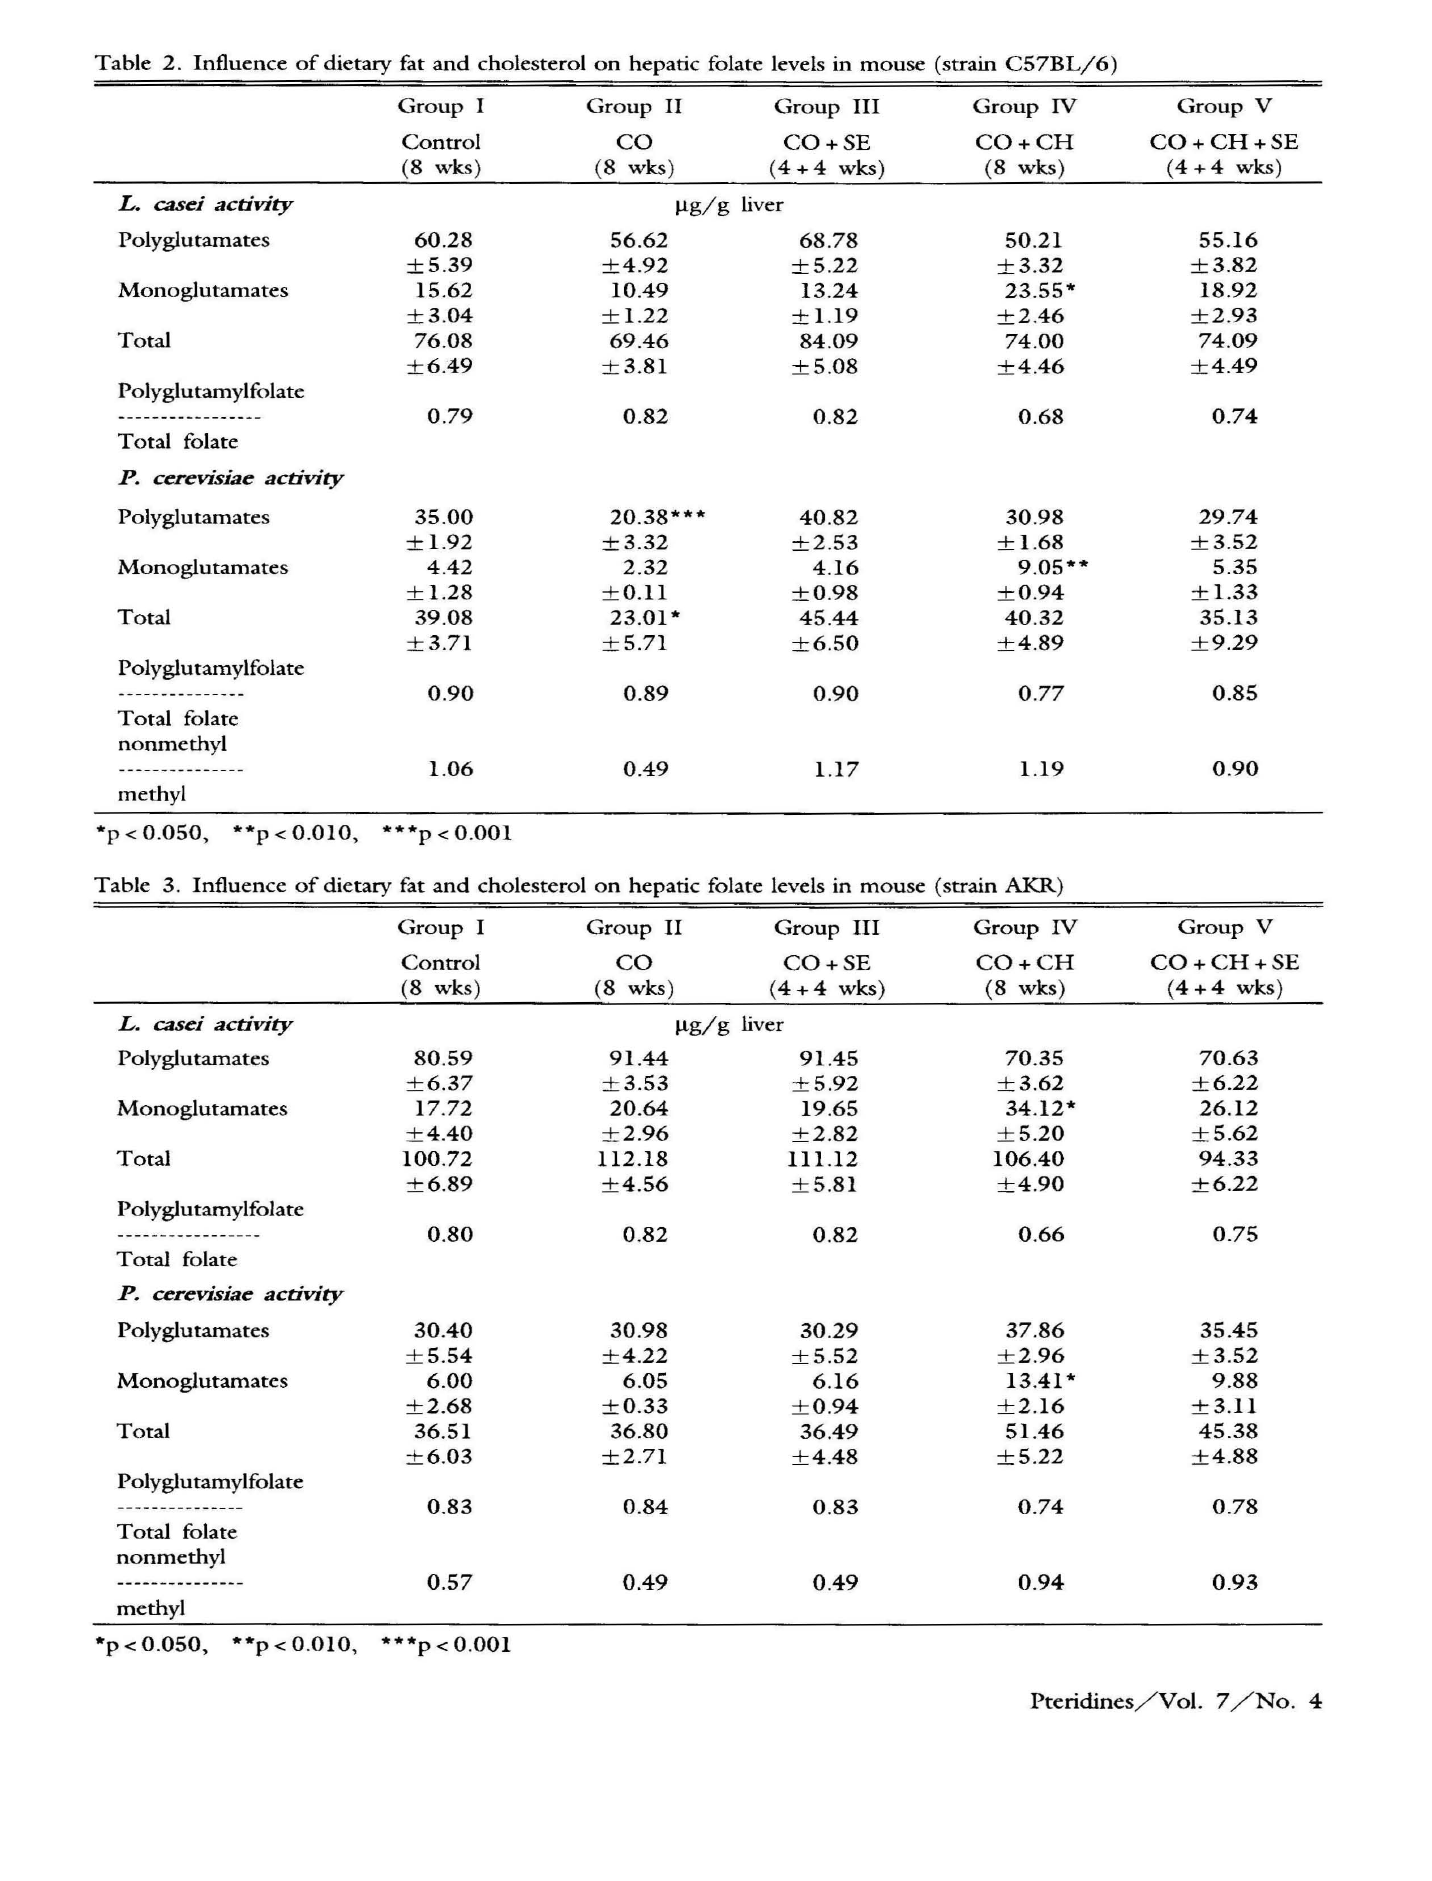
Table 2 . Influence of dietary fat and cholesterol on hepatic folate levels in mouse (strain C57BL/6) Group I